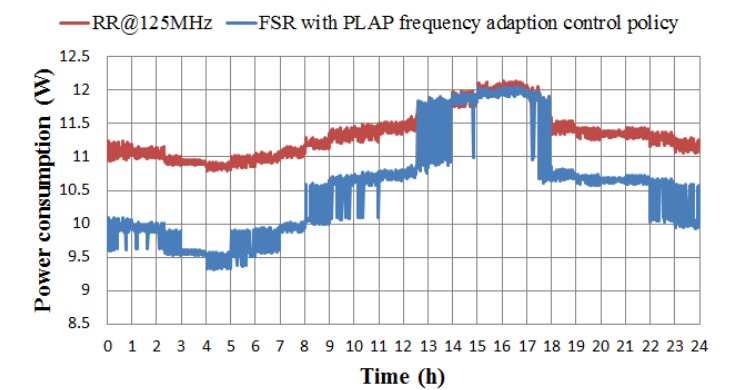
Figure 16. Power consumption corresponding to the traffic trace in Figure 14.